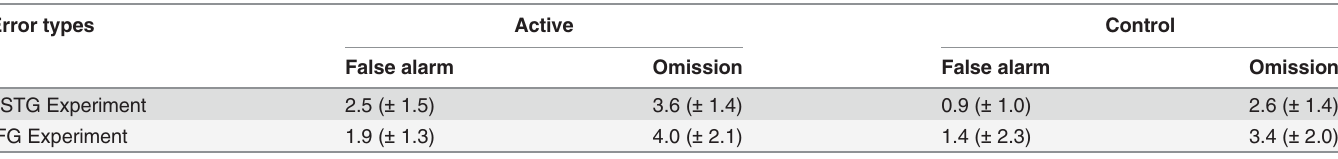
Table 3. Descriptive statistics for the different error